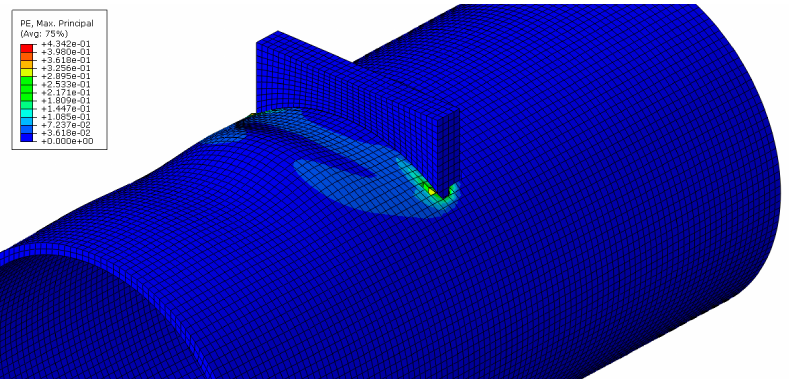
Figure 10. Principal plastic deformation of the tube under localised transverse compression (3D view, Case 10).